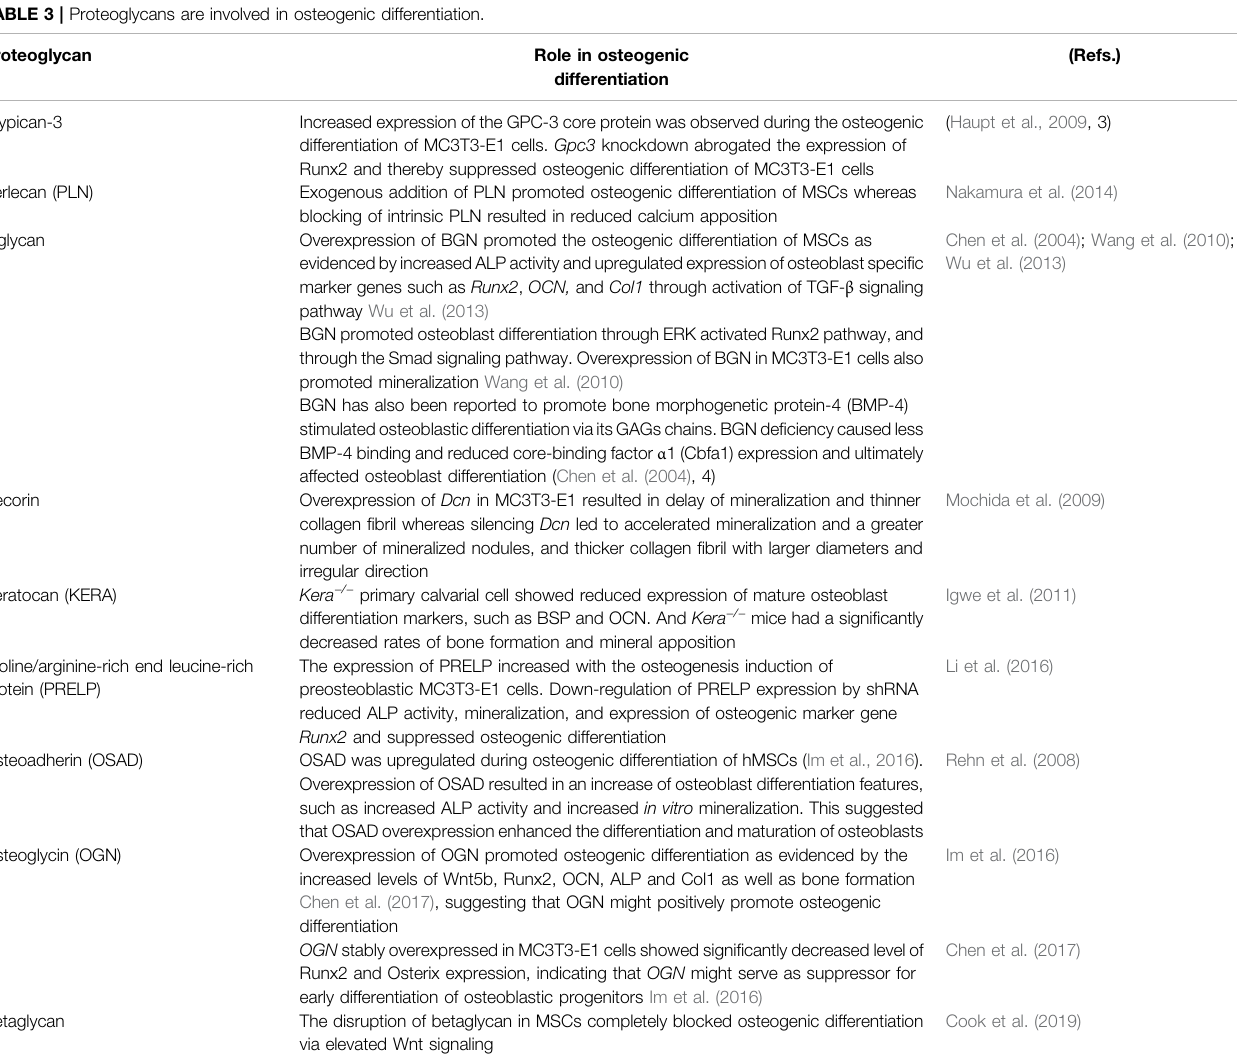
TABLE 3 | Proteoglycans are involved in osteogenic